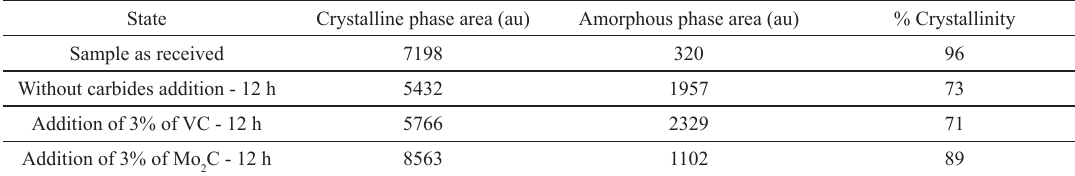
C after 12 hours of milling. 2